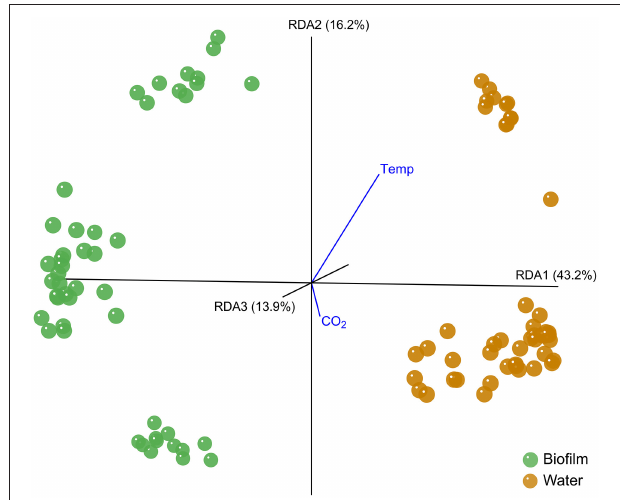
FIGURE 1 | Distance biplot of the type effect. The type effect on Fucus mytili biofilm (green) and water (orange) samples is visualized with KiNG at RDA axes RDA1 43.2%, RDA2 16.2%, and RDA3 13.9% explained variance. Temperature and CO 2 treatment effects are visualized as vectors pointing in negative direction of axis RDA3 (away from the observer). The analysis is based on MiSeq V1-V2 bacterial 16S rDNA amplicon sequence data on 97% sequence